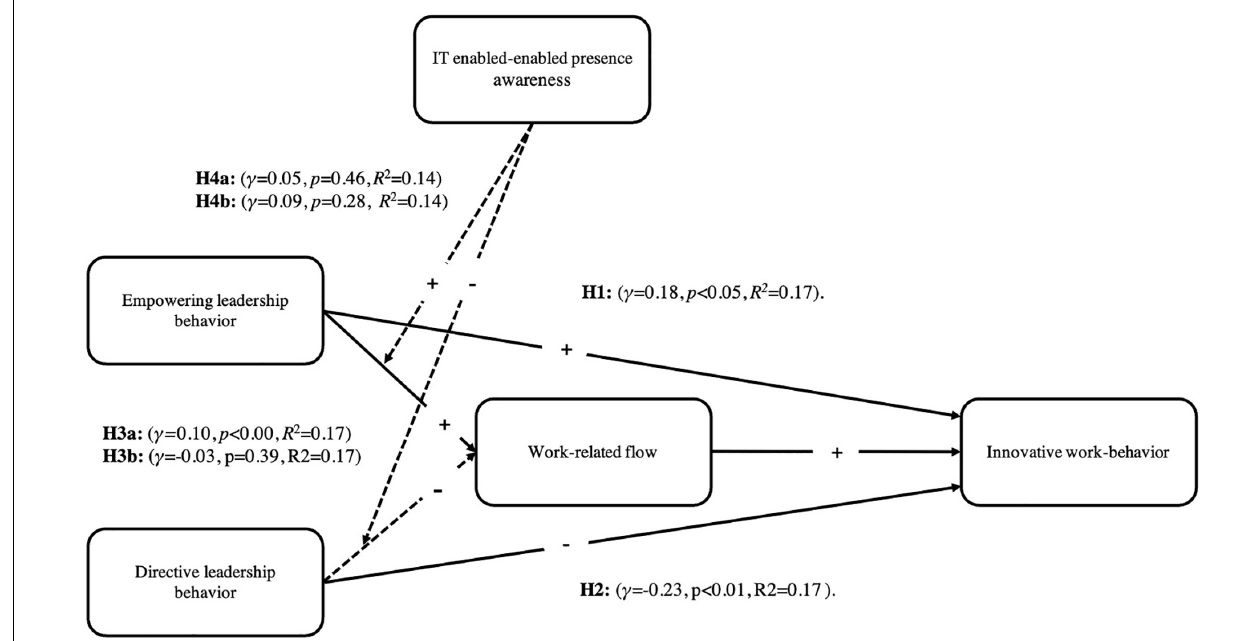
FIGURE 2 | Significant and non-significant relationships of the conceptual model in the first wave.